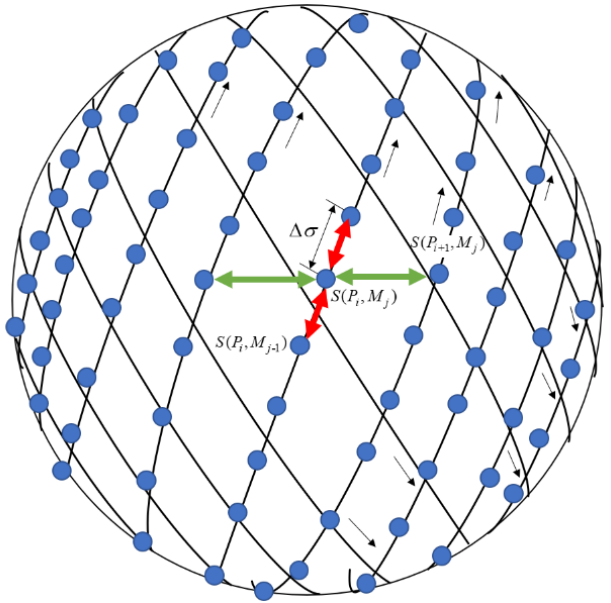
Figure 17. Starlink constellation static topology.